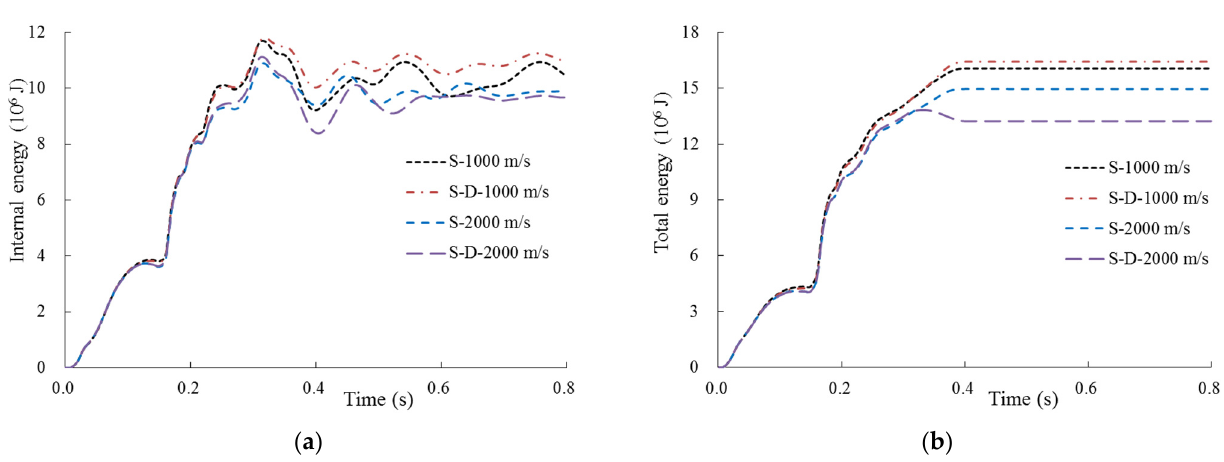
Figure 17. The spring-damper energy and spring energy for the sites of Vs = 1000 and 2000 m/s.